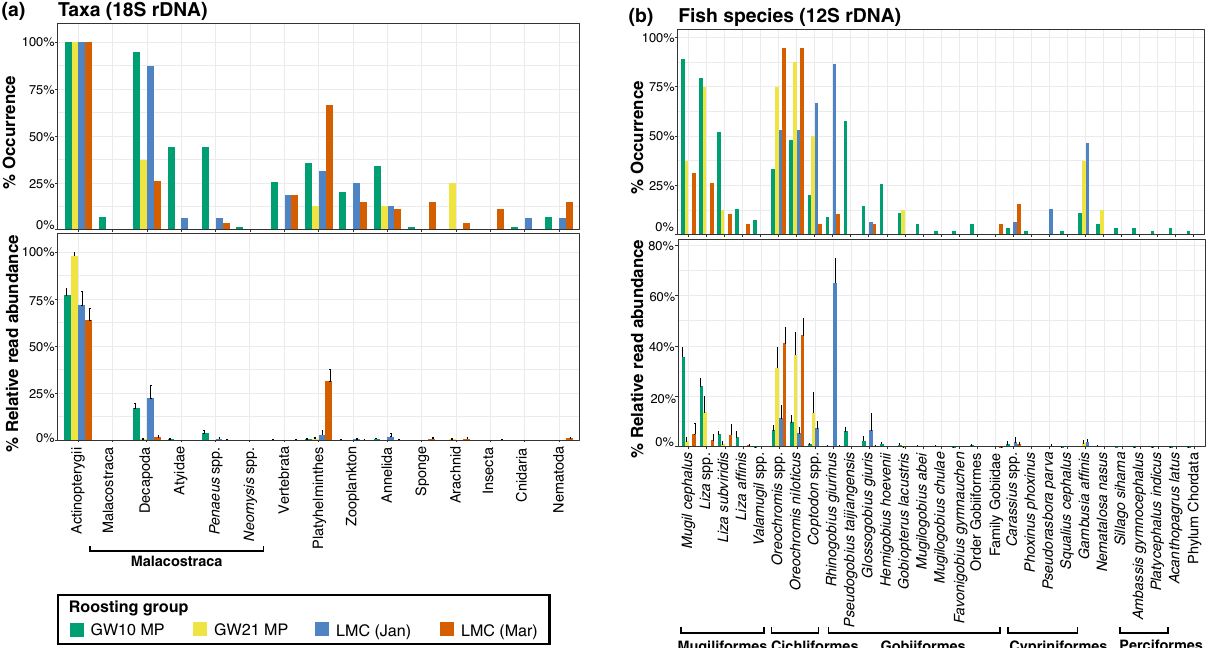
Figure 3. Occurrences and abundances of taxa detected in the fecal samples of Platalea minor based on (a) 18S rDNA (n = 110) and (b) 12S rDNA (n = 96). Frequency of occurrence (upper panel) and means and standard errors of the relative read abundance (lower panel) of each taxon detected in samples from different roosting groups were shown. GW gei wai, MP Mai Po Marshes and Inner Deep Bay, LMC ecological enhancement area of Lok Ma Chau, Jan January, Mar